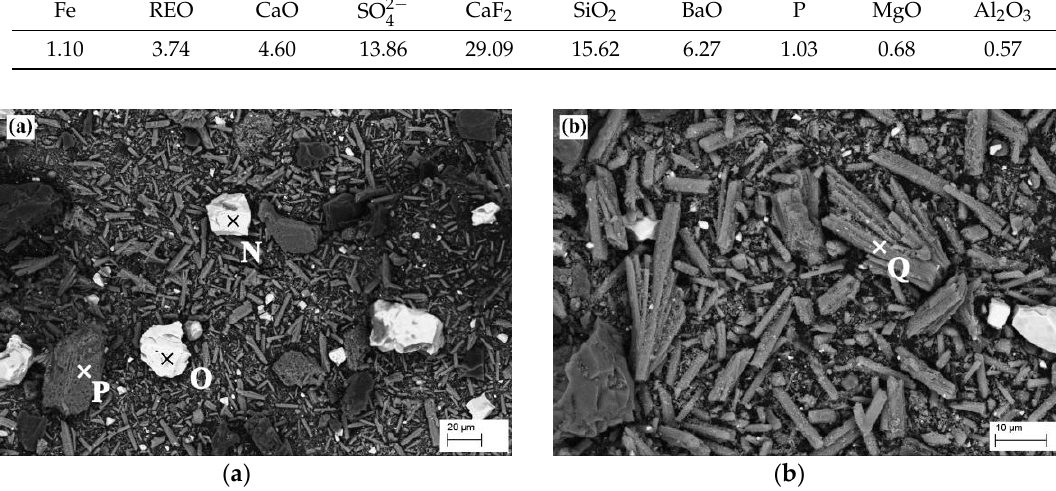
Figure 20. SEM image of the leaching residues ( a and b ): (N) BaSO 4 ; (O) REPO 4 ; (P) SiO 2 ; (Q) CaSO 4 .